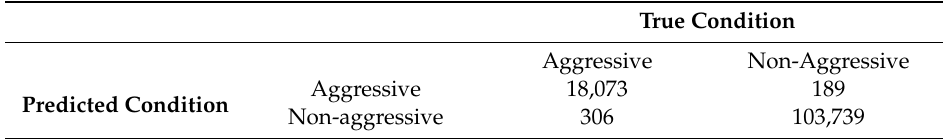
Table 4. K-nearest neighbors (kNN)-ReliefF (ReF) confusion matrix.